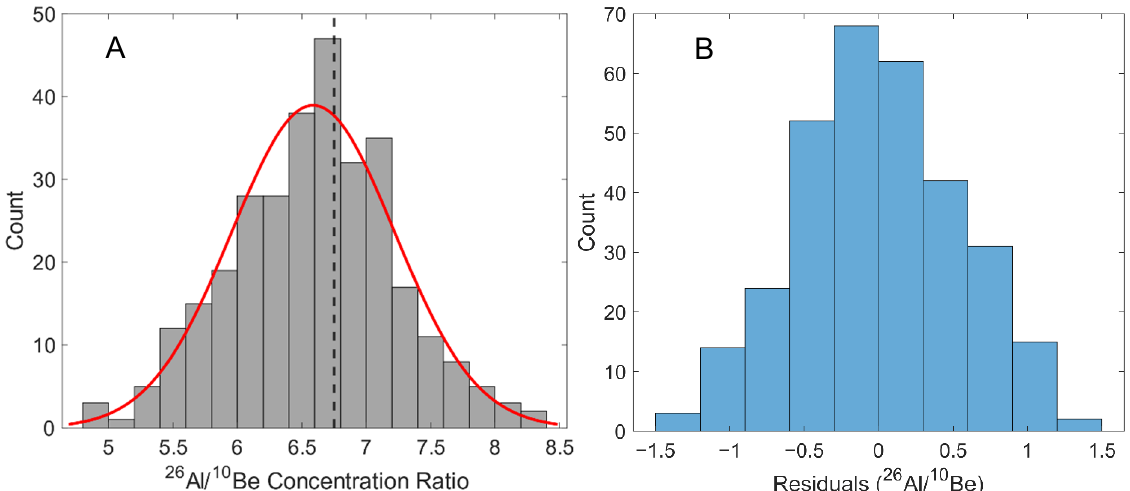
Figure 2. ( A ) Histogram and normal distribution approximation of 26 Al/ 10 Be concentration ratios in the compilation analyzed here. Dashed vertical line shows the currently accepted production ratio value of 6.75. ( B ) Residuals of bi-variate regression model predicting 26 Al/ 10 Be variations due to elevation and latitude.